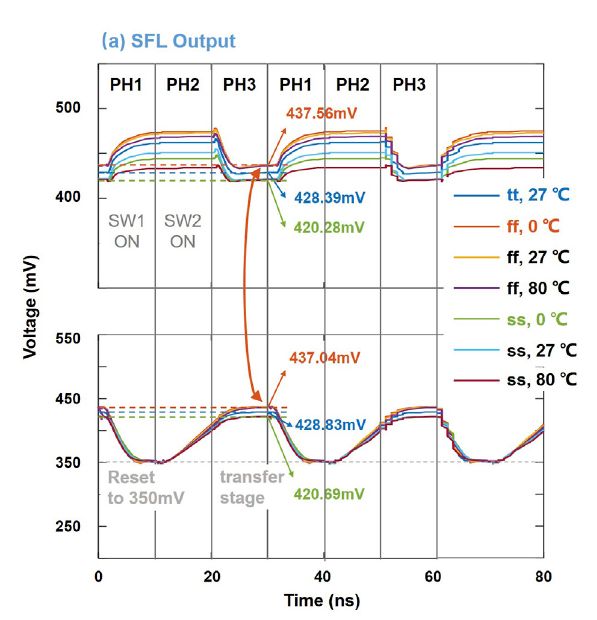
FIGURE 3 Simulation waveforms of the proposed SFL